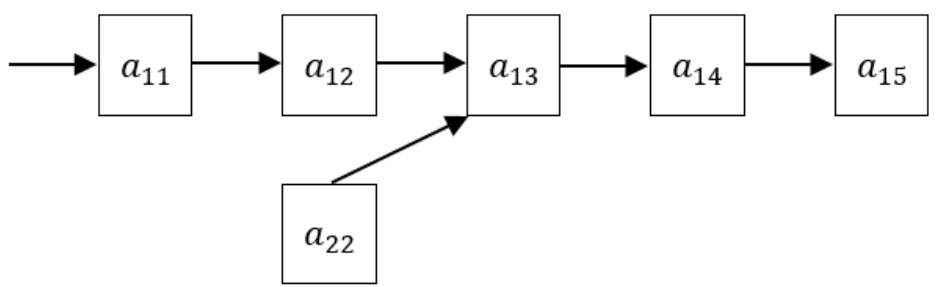
Figure 2. Assembly line with six workstations.